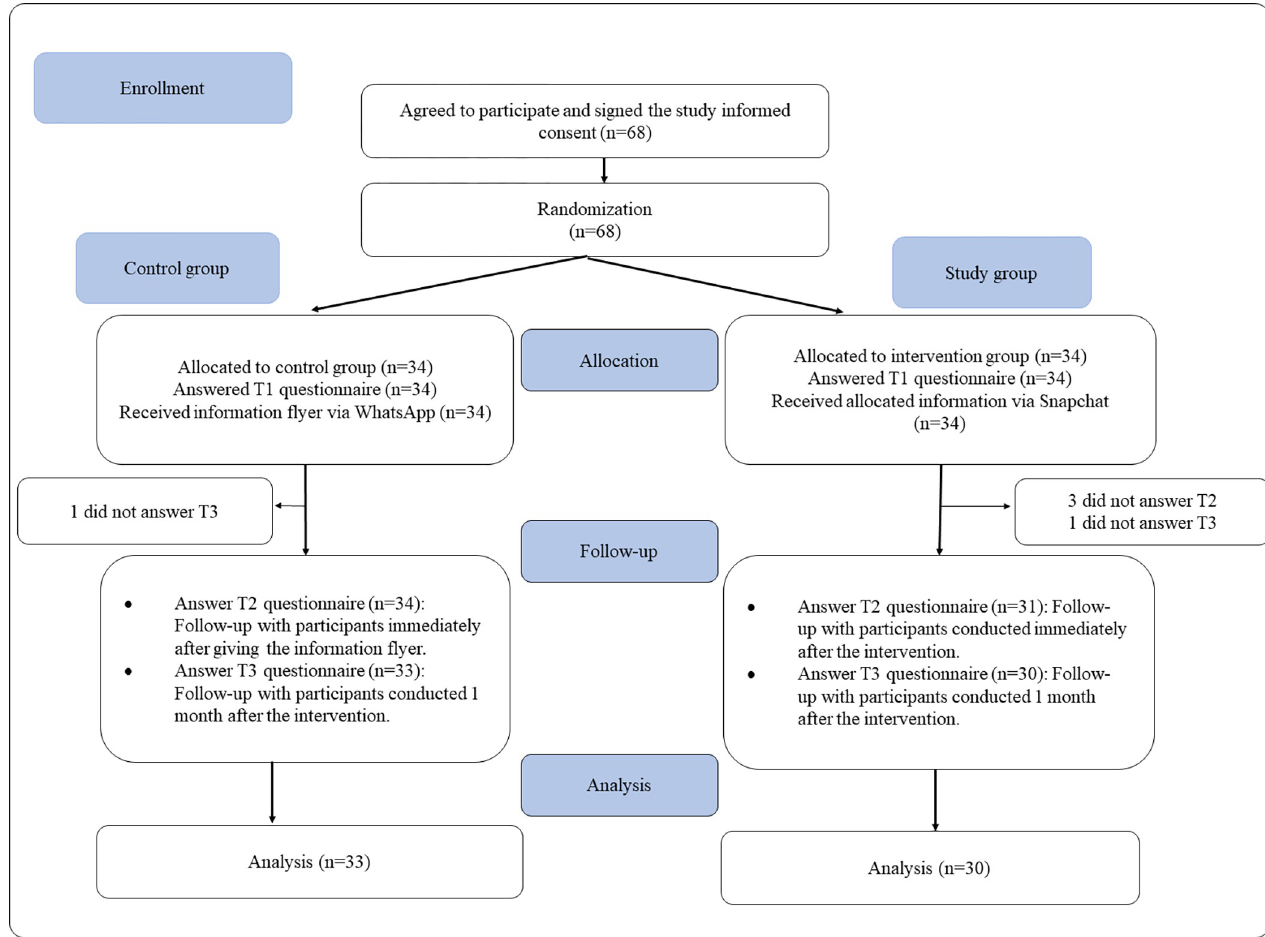
Fig 1. Participant interaction